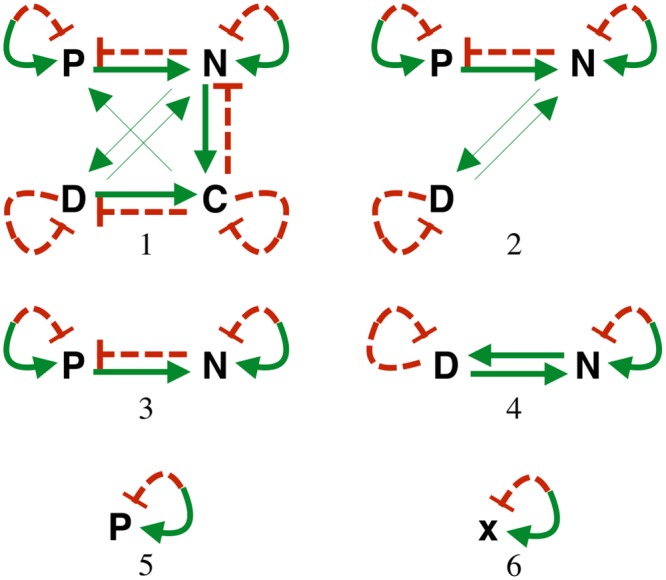
Interactions between variables for models (1)—(6).The green, solid arrows betwen pairs of variables denote upregulation and the red, dashed bars indicate downregulation for ODE models (1)-(6). Combined dashed and solid arrows indicate that either up or downregulation is possible depending on the values of the variables and parameters.